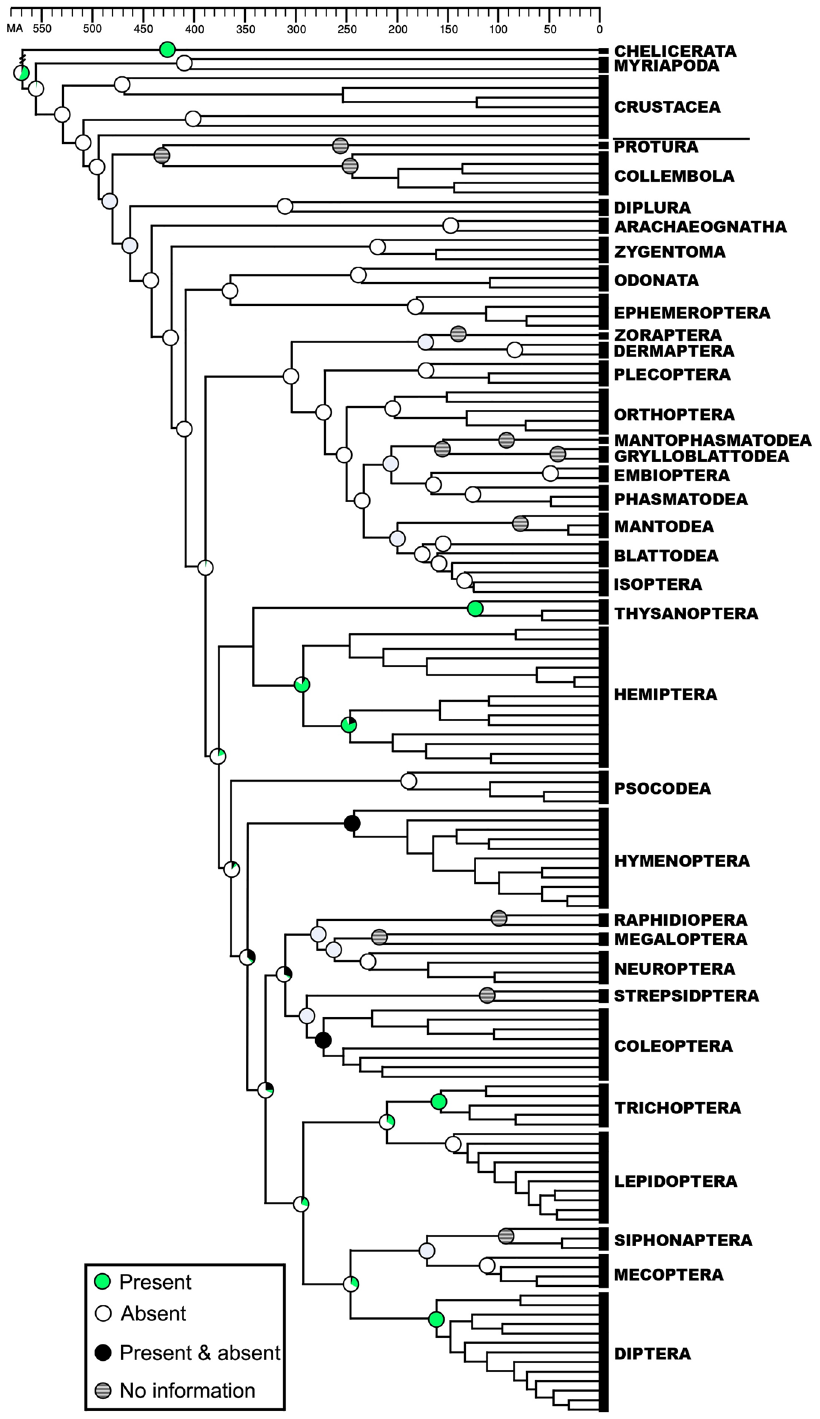
Figure 2. Ancestral state reconstruction of the ability to synthesize trans -zeatin ( t Z) and trans -zeatin riboside ( t ZR) in terrestrial arthropods. Circles in nodes represent the percentage of the probability of the reconstructed character state. The time-calibrated phylogenetic tree is modified from (3). Time Scale is in millions of years before